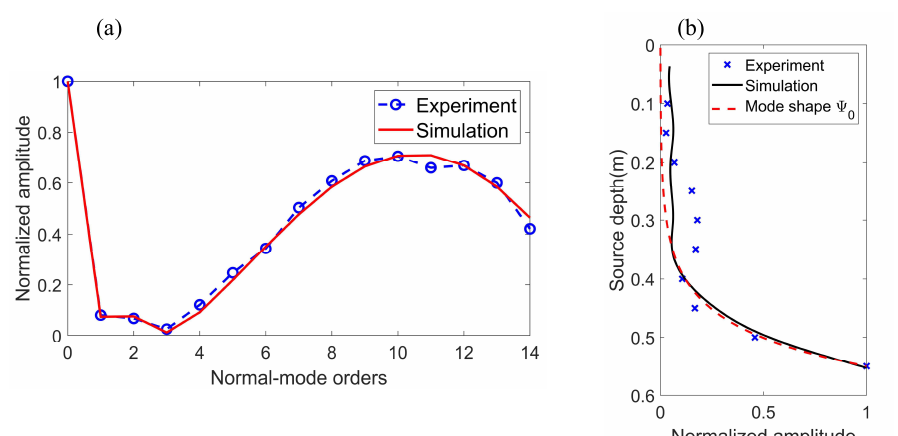
Figure 7. ( a ) Normalized amplitudes of the Scholte wave (0th order) and normal modes for the source depth, SD = 55 cm. The blue circle is the result of the water tank experiment and the red line is the simulation result. ( b ) Normalized amplitudes of the Scholte wave versus source depth. The blue cross is the result of the water tank experiment; the black line is the simulation result; the red dotted line is the mode shape function of the 0th mode.